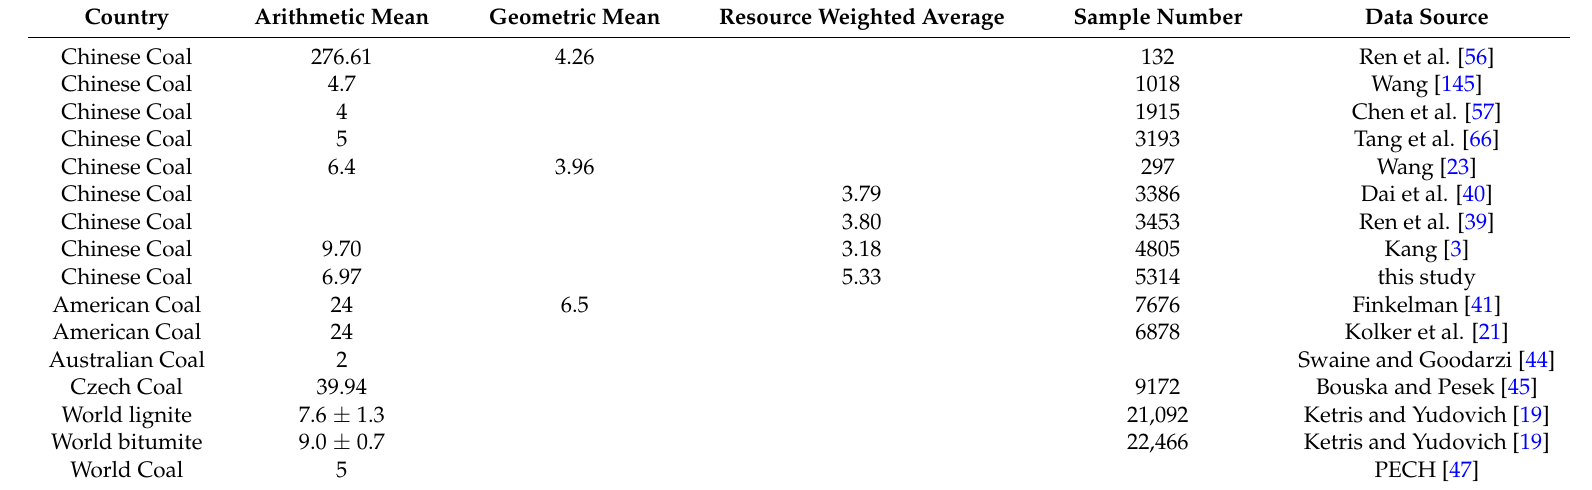
Table 3. Arsenic content in Chinese coals (mg/kg). Data are quoted from references of